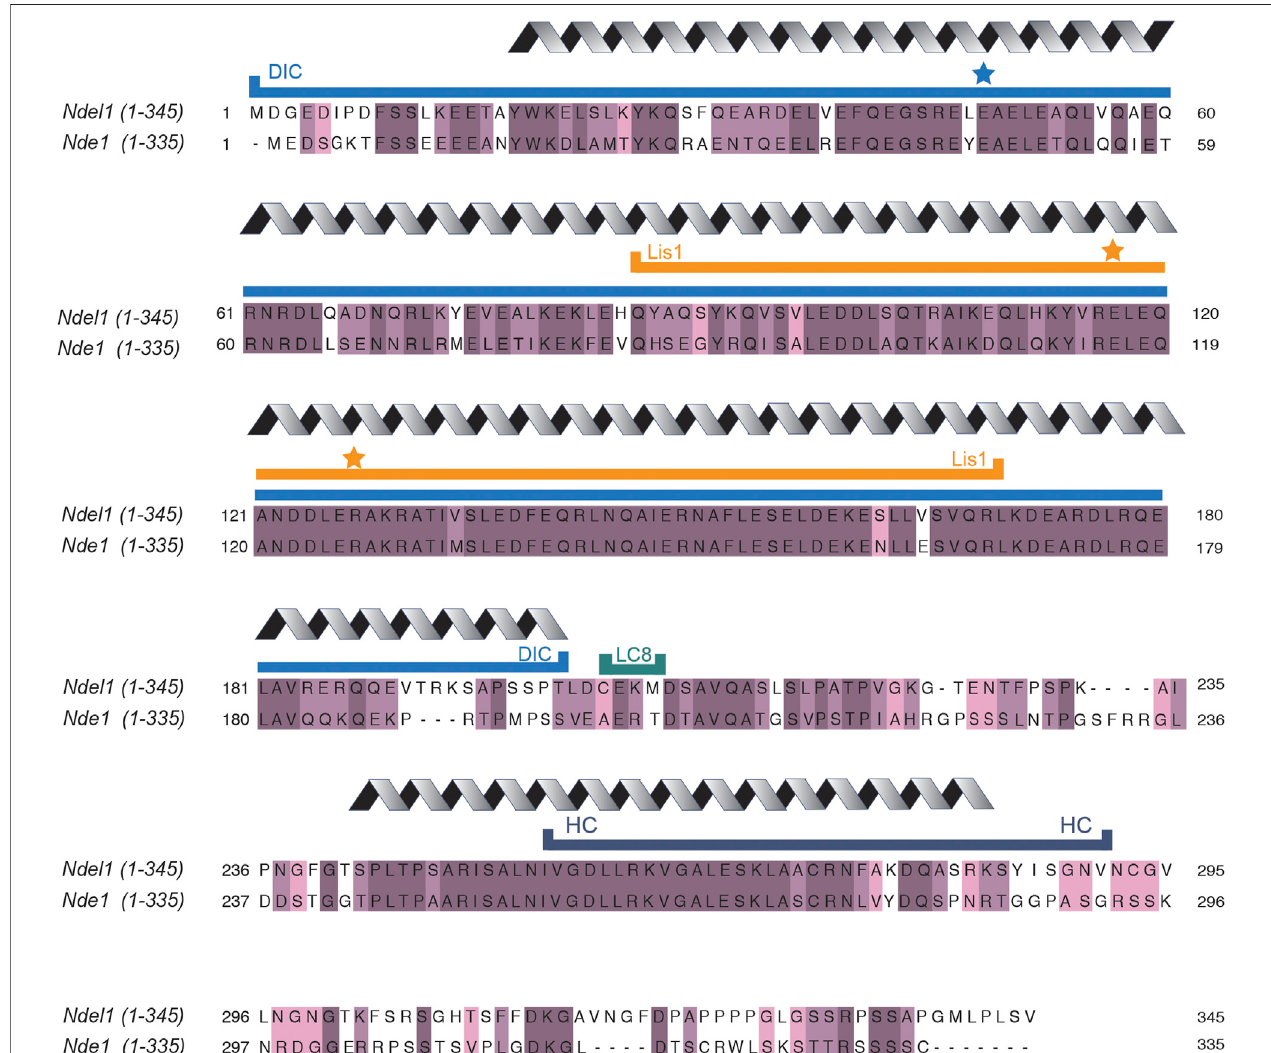
FIGURE 2 | Ndel1 and Nde1 sequence alignments. Sequence alignments of human Ndel1 and Nde1 were performed with Clustal Omega (Sievers et al., 2011). Dark purple indicates residues that are fully conserved, medium purple indicates amino acids that are well-conserved with respect to side chain properties, light purple indicates residues that are weakly conserved. Grey coil above sequence indicates regions that are predicted or observed to be coiled-coils (Derewenda et al., 2007; Ye et al., 2020). All other regions not marked with grey coil are predicted to be random coil or disordered. Minimal regions required to bind dynein intermediate chain (bluelinelabeledwithDIC), Lis1(orangelinelabeledwithLis1),dyneinlightchain8(teal linelabeled withLC8), anddyneinheavy chain(darkblue linelabeled with HC)are indicated. Blue star indicates residues that, when mutated, ablate binding to dynein intermediate chain (Derewenda et al., 2007; Wang and Zheng, 2011). Orange stars indicate residues that, when mutated, ablate binding to Lis1 (Wang and Zheng, 2011; Ż y ł kiewicz et al., 2011; Wang et al., 2013).